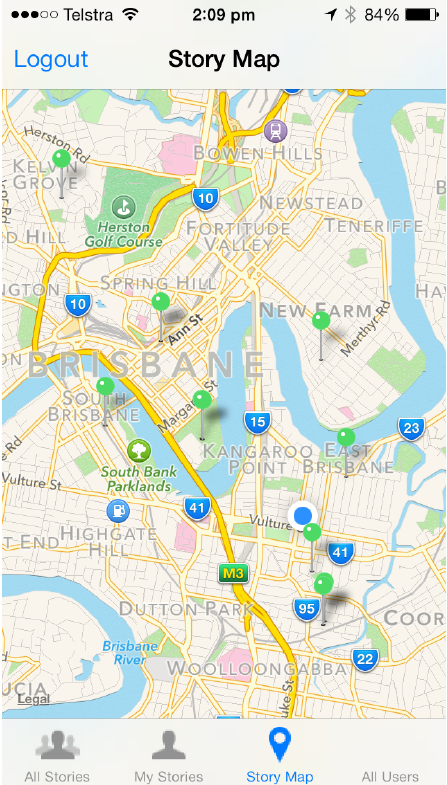
Figure 2. QuickTales application screenshots: Browsing stories by map view.